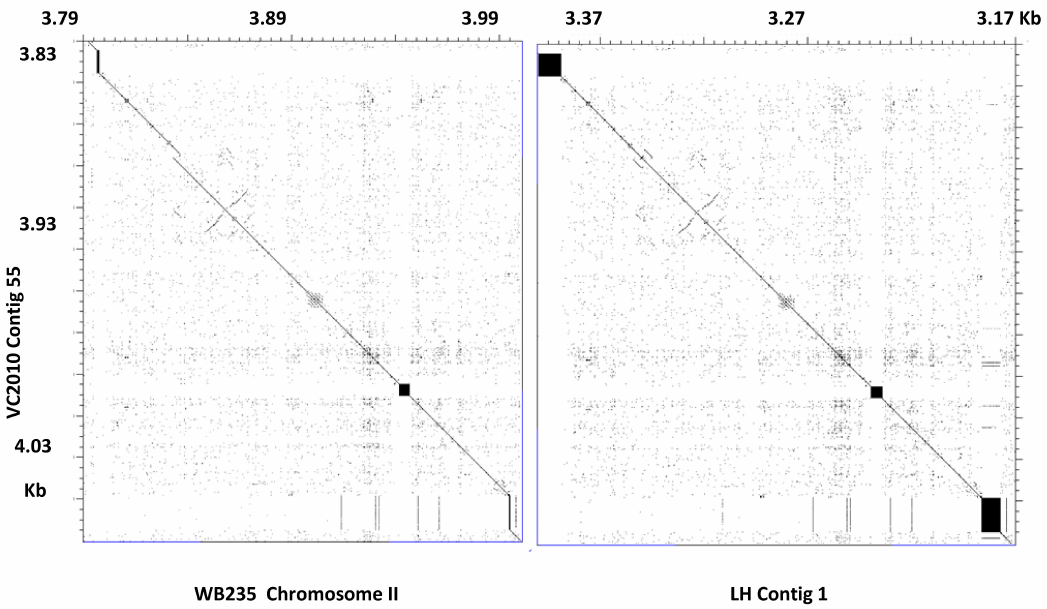
Figure 2. Comparison of a genome region in the three assemblies. The ordinate corresponds to VC2010, and the abscissa to the other assemblies, as indicated in the figure. Three satellites are present in this region, with repeats 24, 79, and 20 bp (from left to right). Their exact coordinates are given in Supplementary Datafile S1. The three satellites are longer in VC2010, especially when compared with WB235. Only the short satellite with repeat 79 is identical in length (5389 bp) in both VC2010 and LH. The neighboring genome regions are identical in LH and VC2010, whereas a small gap and a repeated region are detected in VC2010 and LH at the approximate corresponding position 3,835,000 in WB235. A gene ( oac-4 ) is present here [8]; according to the VC2010 and LH data, it should be longer by about 2 kb. The figure was prepared with the Dotter program